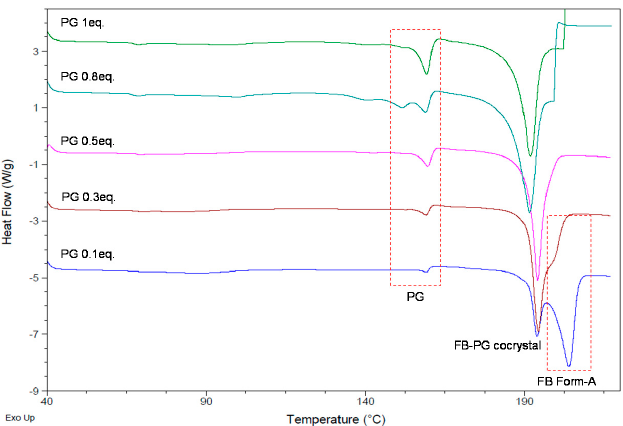
Figure 2. Differential scanning calorimetry (DSC) curves of febuxostat (FB)/ L -pyroglutamic acid (PG) solid mixtures obtained under PG composition (equivalent) change (heating rate: 10 ° C/min, Temperature range: 40–250 ° C).